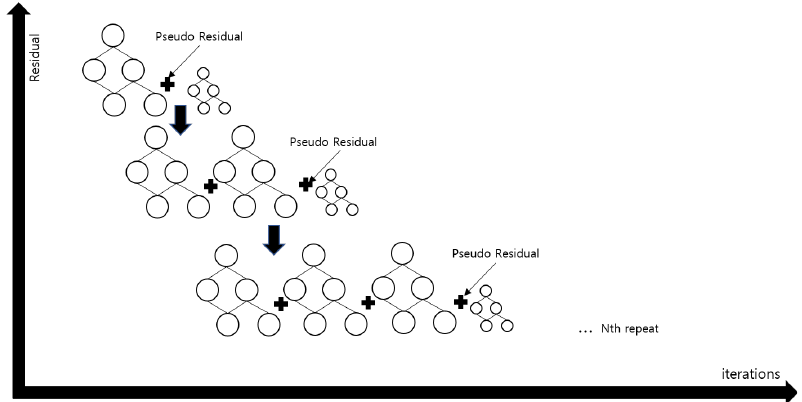
Figure 7. Structure of a GBM.